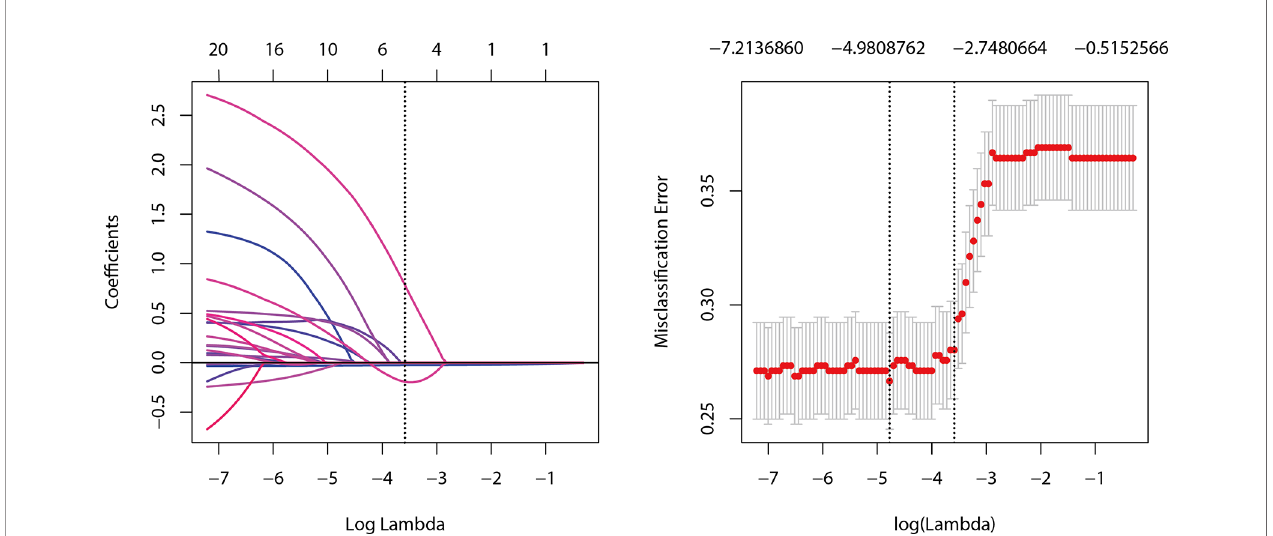
FIGURE 2 | Selection of ultrasound features using the Group LASSO regression in the development dataset.